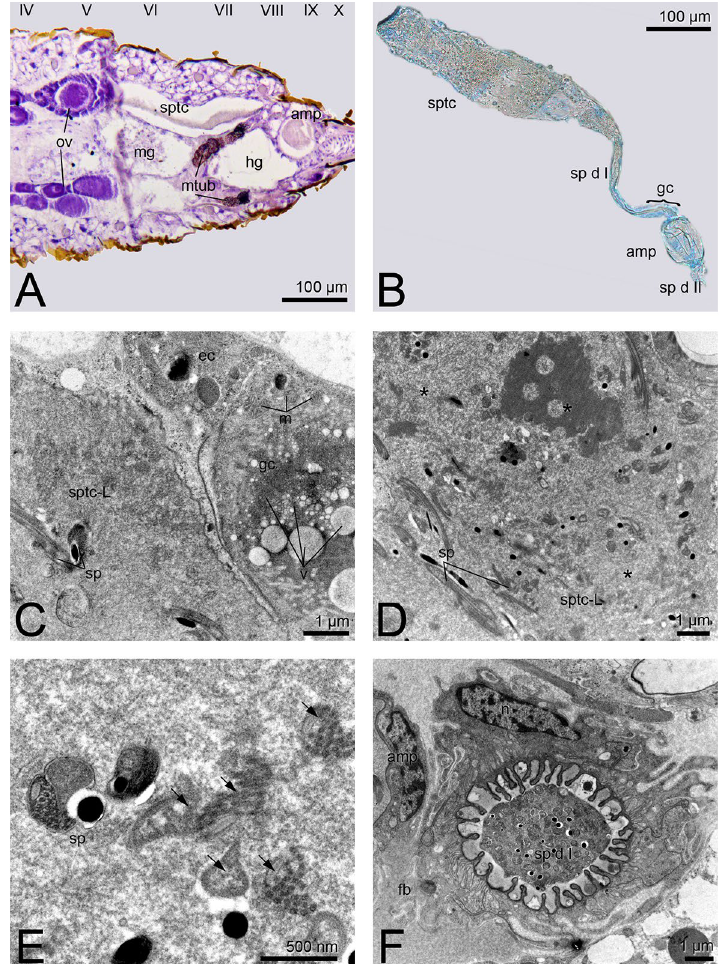
Figure 1. Suocerathrips linguis , ( A) position of spermatheca and ampoule in the female’s abdomen, frontal section of segments IV to X; ( B) dissected spermatheca and ampoule with connecting ducts; ( C ) ultrastructure of spermatheca in the border area between lumen, gland- and epithelial cell, ( D ) lumen of the spermatheca filled with secretion and spermatozoa; ( E ) close up of intact and defective sperm within the spermatheca lumen; ( F ) spermathecal duct which connects the spermatheca and the ampoule filled with secretion and sperm, transverse